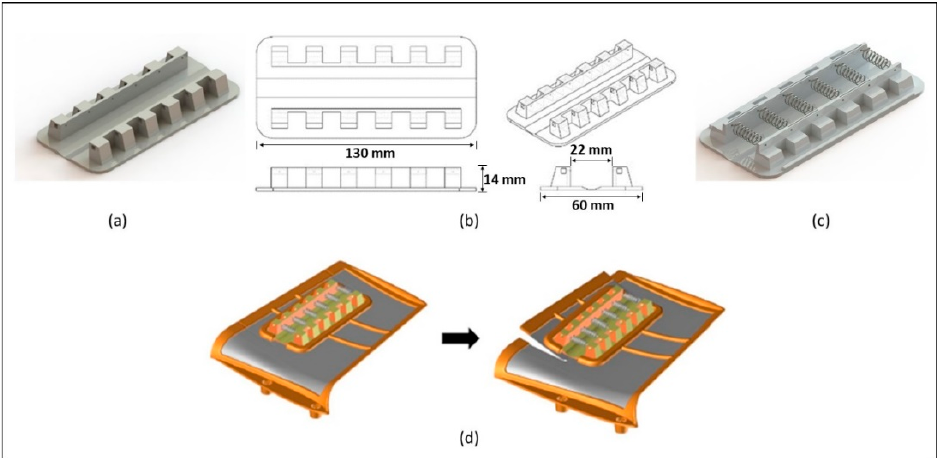
Figure 2. Geometry and assembly of prototype: ( a ) nylon support; ( b ) scheme; ( c ) support with SMA wire and springs; ( d ) aircraft component system before and after SMA actuator effect.